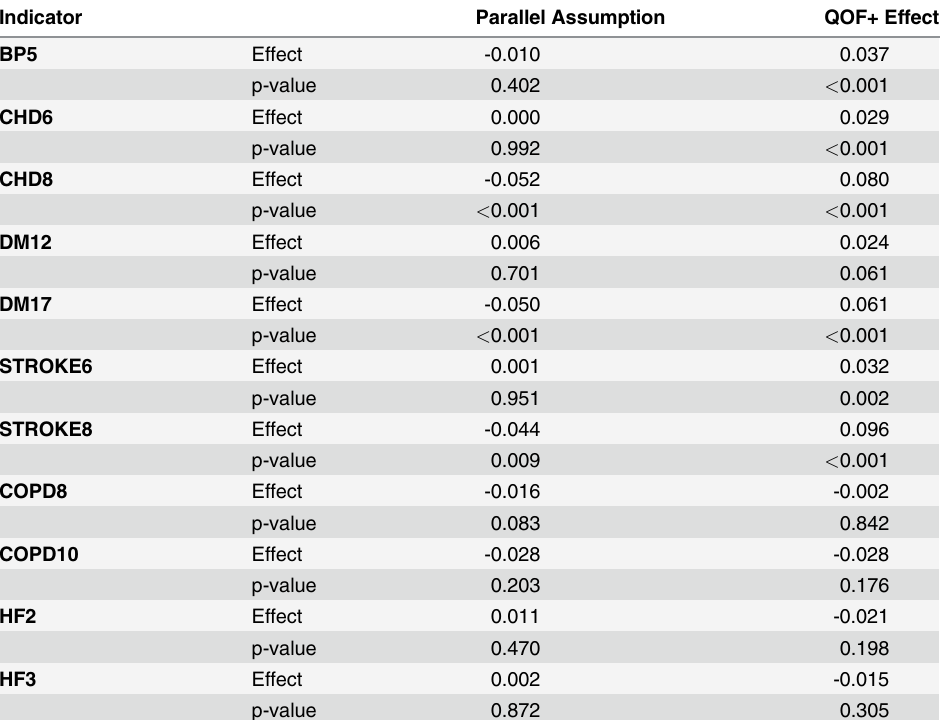
Table 3. Results for the national comparison based on a difference-in-difference model.